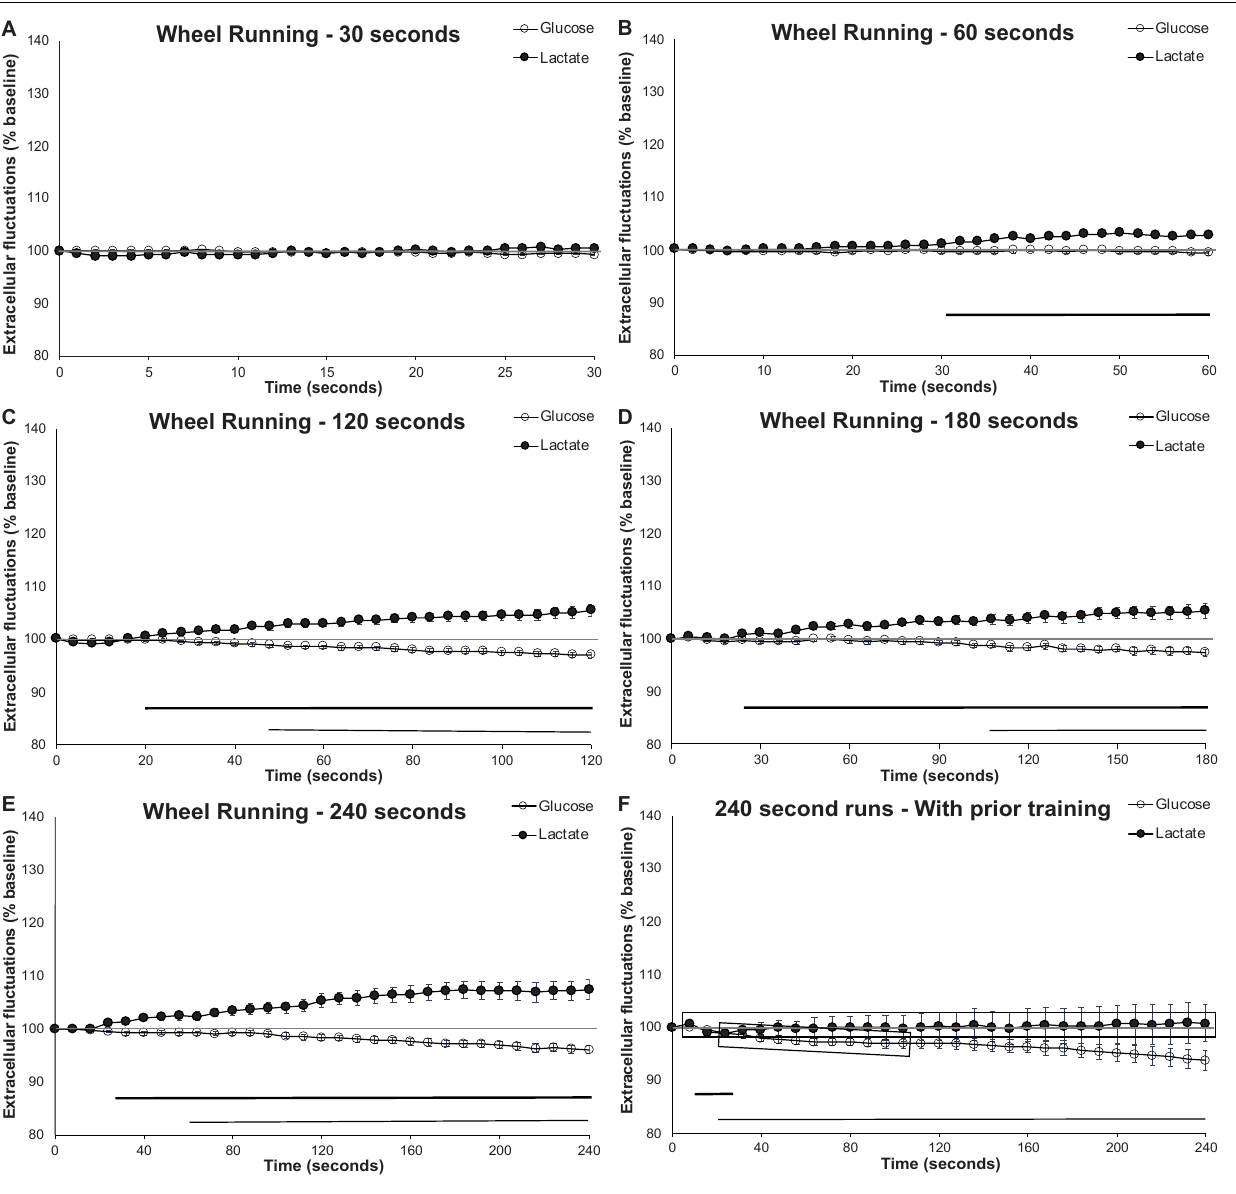
FIGURE 2 | Extracellular glucose and lactate fluctuations during voluntary wheel running. Extracellular cortical glucose (open circle) or lactate (filled circle) during voluntary wheel running for individual running events lasting between (A) 30–59 s ( n events = 32, 10 mice), (B) 60–119 s ( n event = 58, 10 mice), (C) 120-179 s ( n events = 35, 10 mice), (D) 180–239 s ( n events = 31, 10 mice), or (E) 240 + seconds ( n events = 36, 10 mice). (F) Running events of at least 240 s taken from mice ( n = 4) who were previously exposed to the running wheel for 4 weeks ( n events = 29). Time zero corresponds to the mouse initiating running. Values are expressed as a percent of their baseline taken prior to activity and the error bars indicate the standard error of the mean. The mid-graph gray line shows baseline (100%) value. Horizontal lines below the data indicates significant ( p < 0.05) differences from baseline for both extracellular glucose (thin line) and lactate (thick